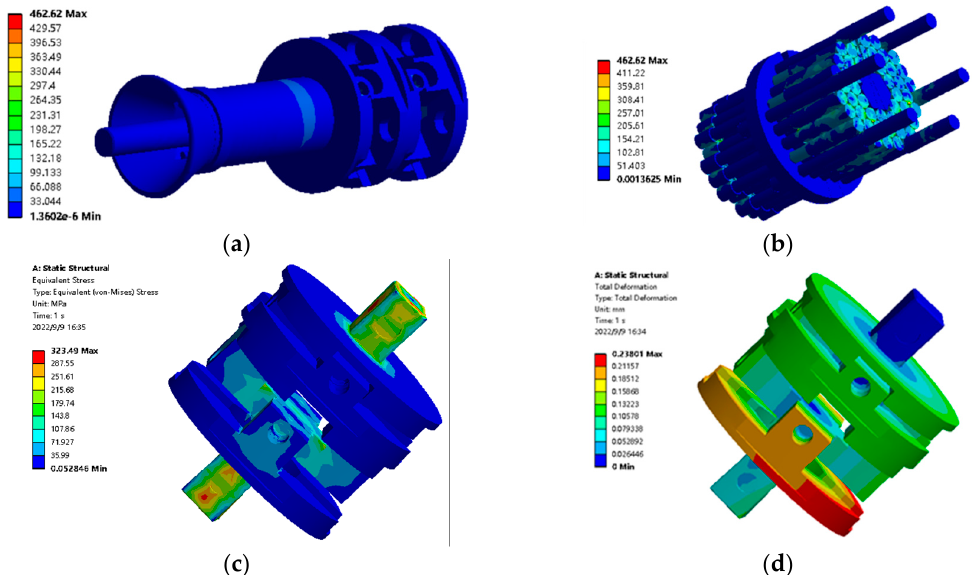
Figure 22. Finite element analysis results. ( a ) Global stress distribution of end-effector. ( b ) Stress distribution of steel bars. ( c ) Stress distribution of flexible connecting mechanism. ( d ) Strain distribution of flexible connecting mechanism.